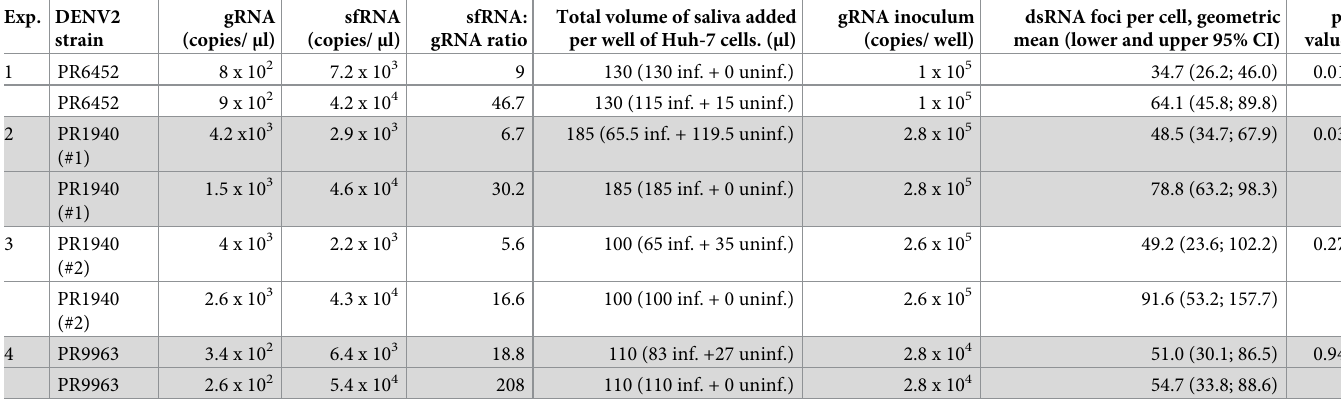
Table 1. Higher sfRNA:gRNA ratio in mosquito saliva increases DENV2 infection of human cells. The experiment number, identity of the virus strain, concentration of gRNA and sfRNA, and sfRNA:gRNA ratio for pools of salivas collected from DENV2 infected mosquitoes are shown in the first five columns. The total volume of sali- vary inoculum (volume of infected saliva (inf.) + volume of uninfected saliva (uninf.)) used to infect Huh-7 cells and the gRNA copies added per well of Huh-7 cells are indicated in columns six and seven. The geometric mean, lower and upper 95% CI of dsRNA foci per cell at 2 days post infection are in column